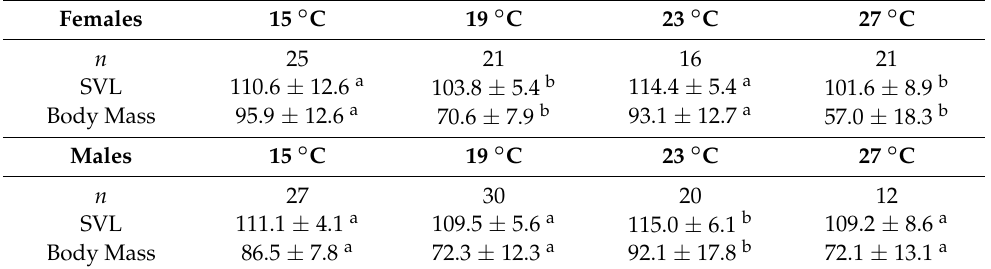
Table 1. Effects of rearing temperature (15 ◦ C, 19 ◦ C, 23 ◦ C, and 27 ◦ C) on snout-vent-length (SVL) (mm) and body mass (g) of female and male axolotls, Ambystoma mexicanum . Different letters indicate statistically significant differences among temperatures. Mean ± standard